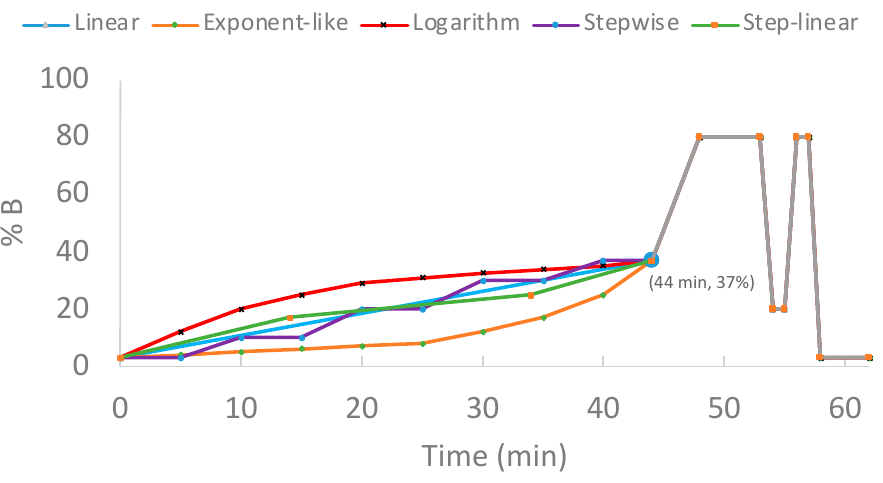
Figure 13. Gradient structures. A set of 44 min gradient types (62 min run time) were comprised of linear (blue), exponent-like (orange), logarithm-like (red), stepwise (purple), step-linear (green). For the first 44 min, linear had a gradient of 3–37% B over 44 min; exponent-like had a gradient of 3–8% B over 25 min, three 5 min serial gradients to 12% B, 17% B, and 25% B, prior to 37% B for 4 min; logarithm-like had eight 5 min serial gradients from 3% B, to 12% B, 20% B, 25%, 29% B, 31% B, 32.5% B, 33.9% B, and 35% B, prior to 37% B for 4 min; stepwise hold at initial 3% B for 5 min,